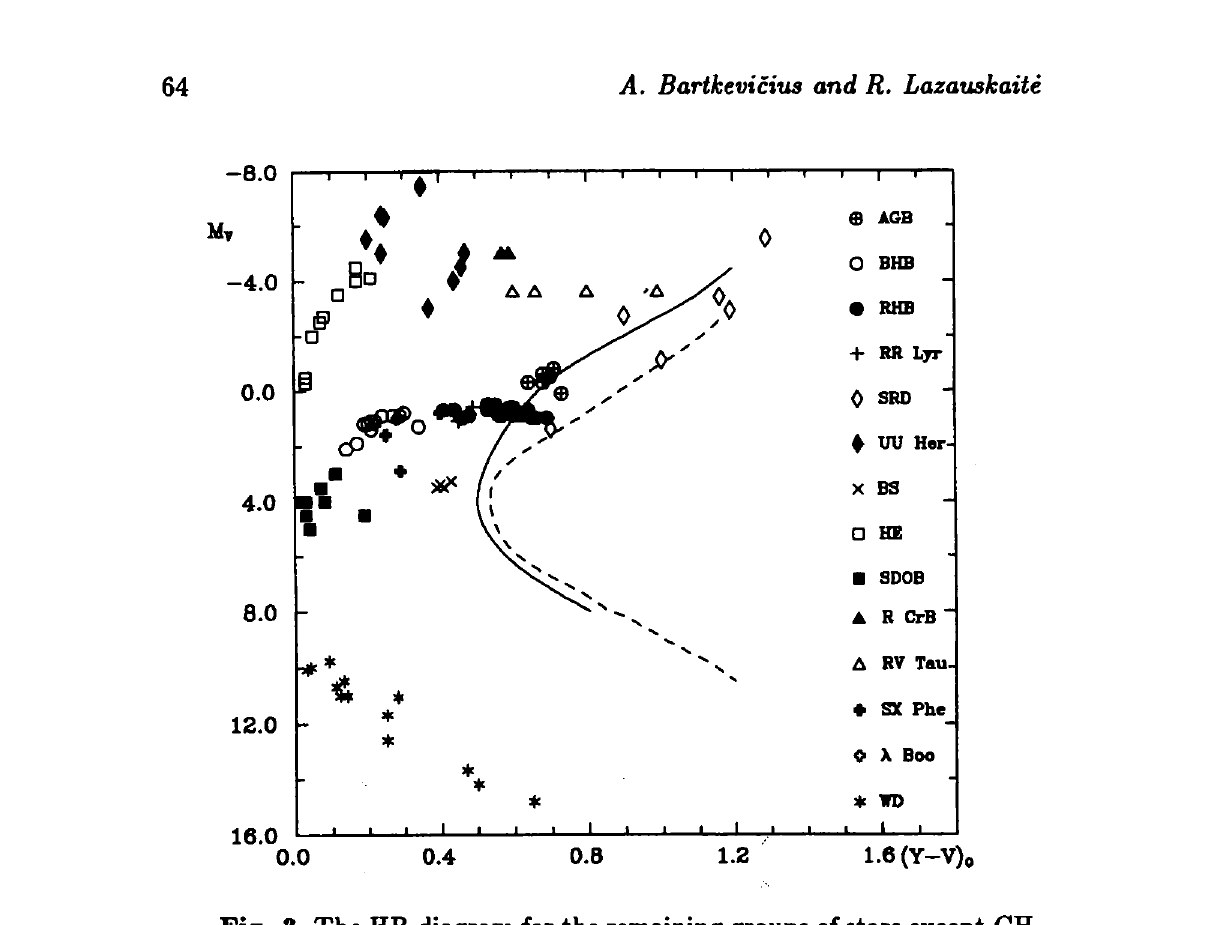
Fig. 3. The HR diagram for the remaining groups of stars except CH, MD-Ba and WG stars. The dashed line is the mean sequence of subdwarfs and giants with moderate metal deficiency ([Fe/H] > -1.3). The solid line is the mean sequence of subdwarfs and giants with large metal-deficiency ([Fe/H] <